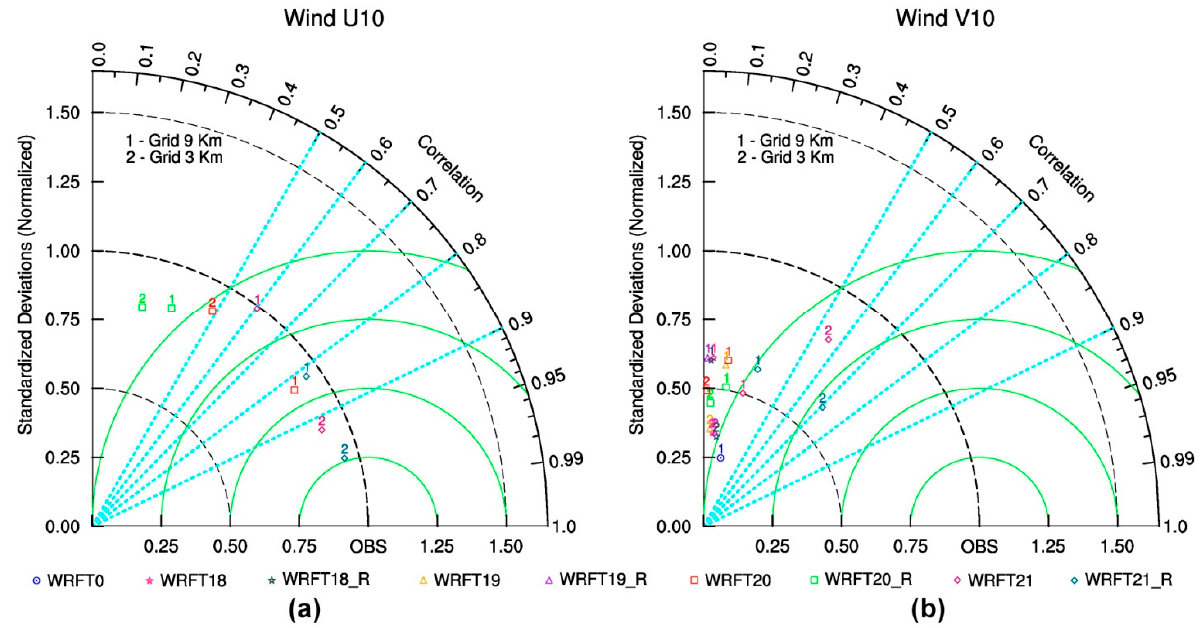
Figure 6. Taylor diagrams for zonal (panel ( a )) and meridional (panel ( b )) wind components, with statistics normalized with respect to observations. Numbers 1 and 2 indicate the outer grid (9 km) and the inner grid (3 km), respectively. The blue circle identifies the control run while the other marks identify runs with data assimilation until 18:00, 19:00, 20:00, and 21:00 UTC, 4April 2019. The best configurations are those for which the nudging ends at 21:00 UTC; their performance is the best in terms of correlation for U10, and in terms of both correlation and normalized standard deviation for V10. The statistical indices in the inner grid are